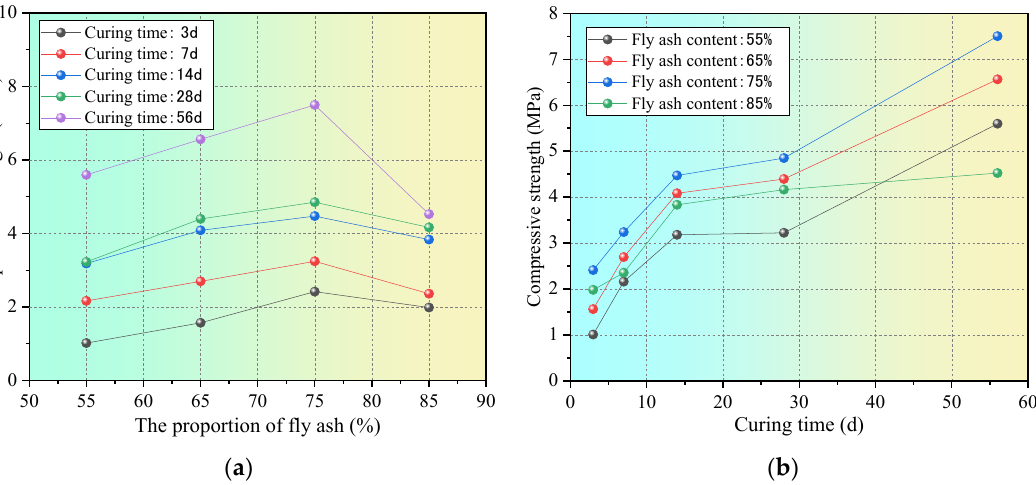
Figure 5. The UCS of CMFB with various fly ash contents and curing times. ( a ) various fly ash contents; ( b ) various curing times.